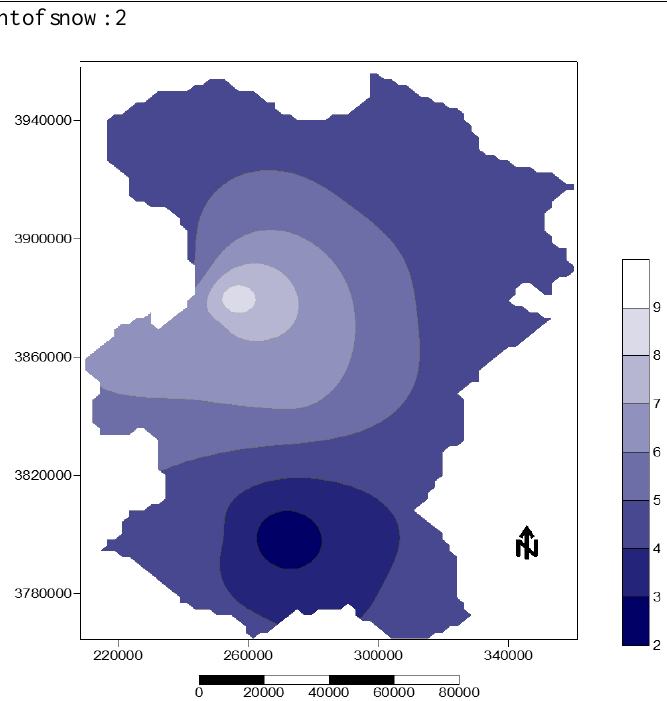
Fig. 3. Zoning of snow in Gamasyab and Gharechay